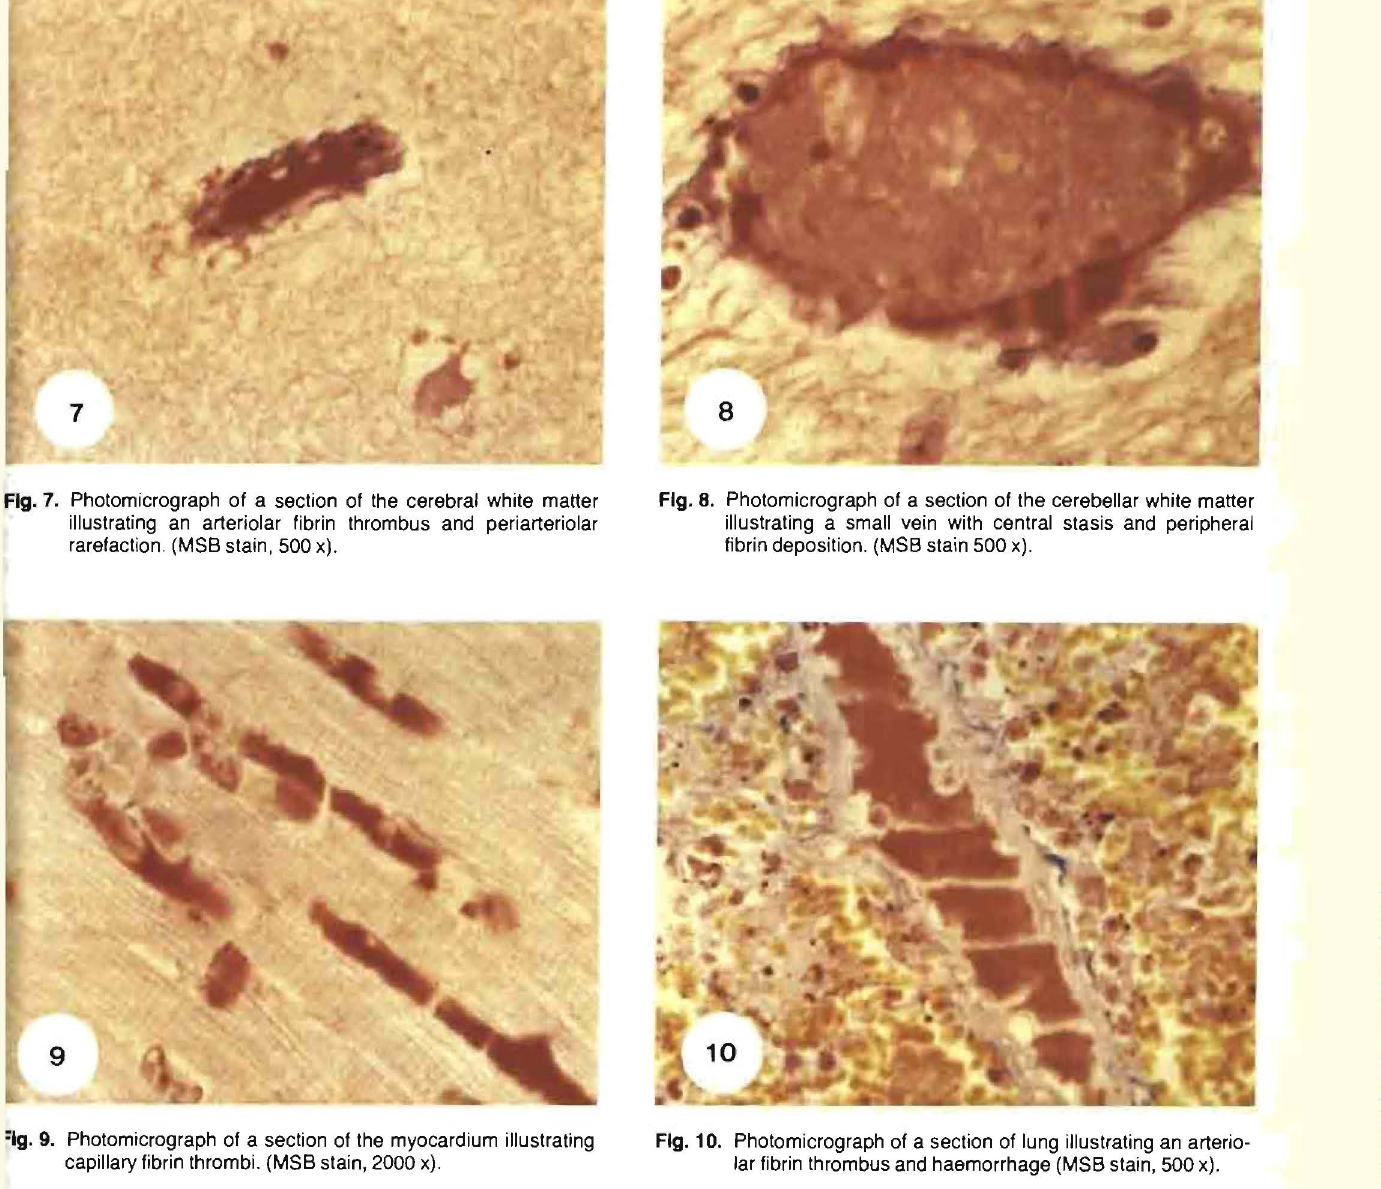
Fig. 8. Photomicrograph of a section of the cerebellar white matter illustrating a small vein with central stasis and peripheral fibrin deposition. (MSB stain 500 x).